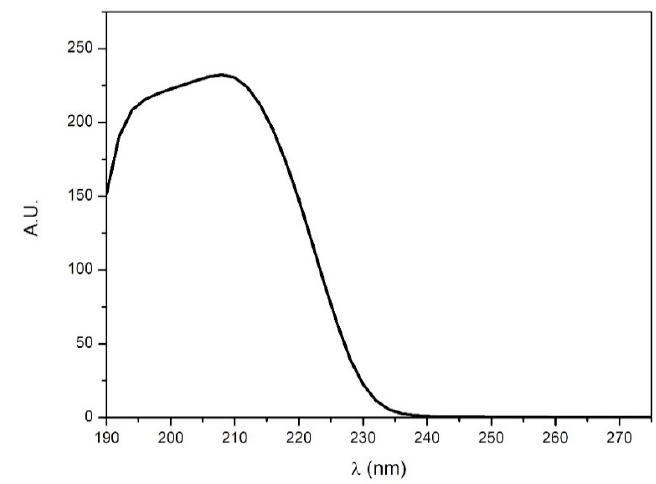
Figure 1. UV-Vis spectrum of a histamine standard aqueous solution at 40 mg L − 1 . The UV-DAD chromatograms at 210 nm of the standard solution, a sample spiked at 200 mg kg − 1, and a blank sample are shown in Figure 2.